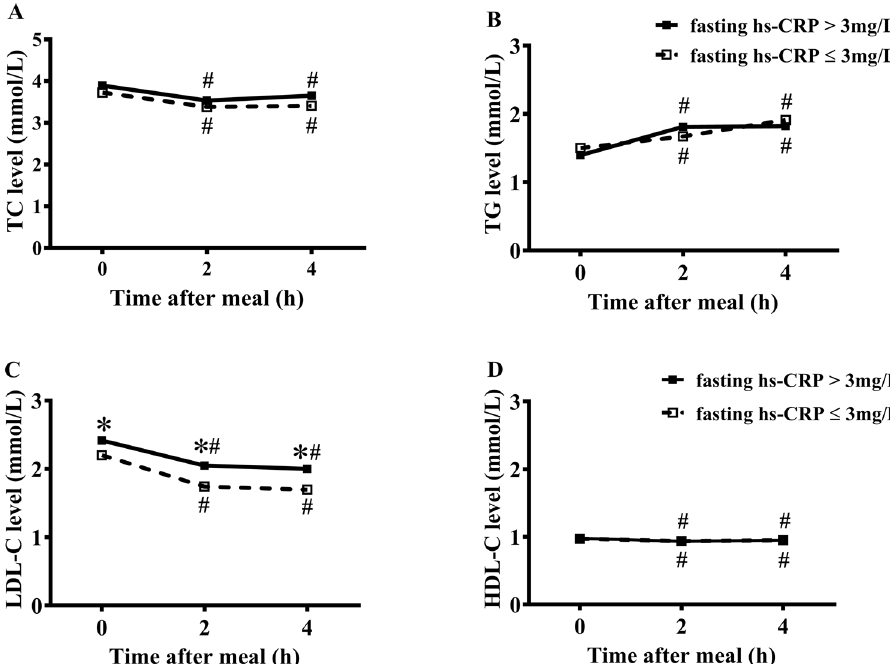
Figure 1. Comparisons of changes in levels of blood lipids after a daily meal between two groups. ( A – D ) The changed levels of TC ( A ), TG ( B ), LDL-C ( C ) and HDL-C ( D ) in two groups (i.e., CHD patients with fasting hs-CRP level ≤ 3 mg/L or not). * P < 0.05 when compared with fasting hs-CRP ≤ 3 mg/L group at the same time point, # P < 0.05 when compared with the fasting concentration in the same group.